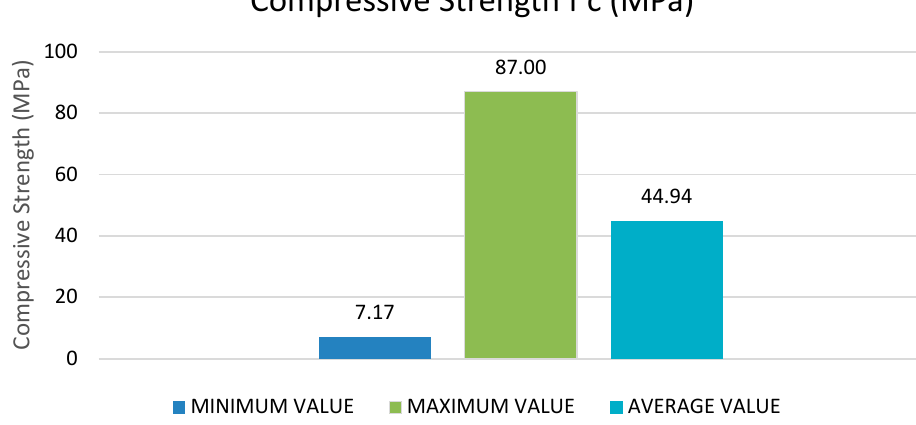
Figure 2. Minimum, mean and maximum values of output variables.